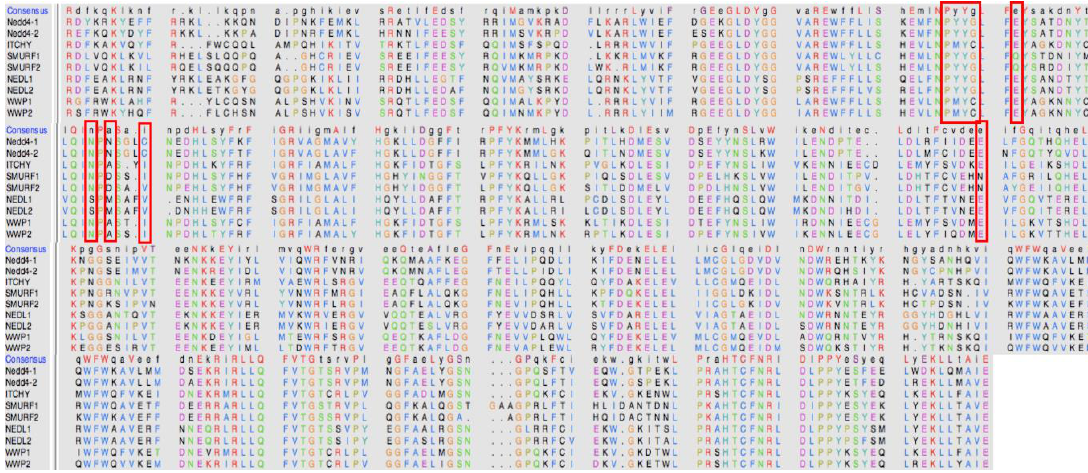
Figure 7. Sequence alignment of the nine members of the Nedd4 family .